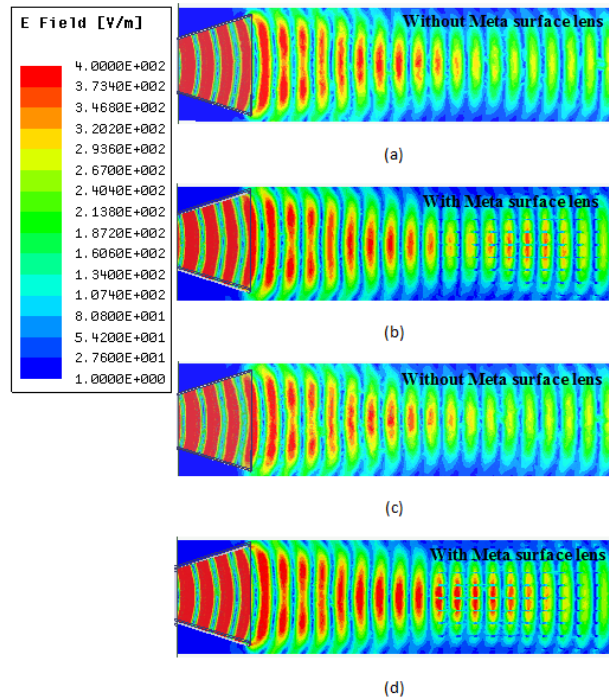
Figure 6: E-field distribution – (a) and (b) without and with metasurface lens at 9.7GHz, (c) and (d) without and with metasurface lens at 10GHz, respectively.